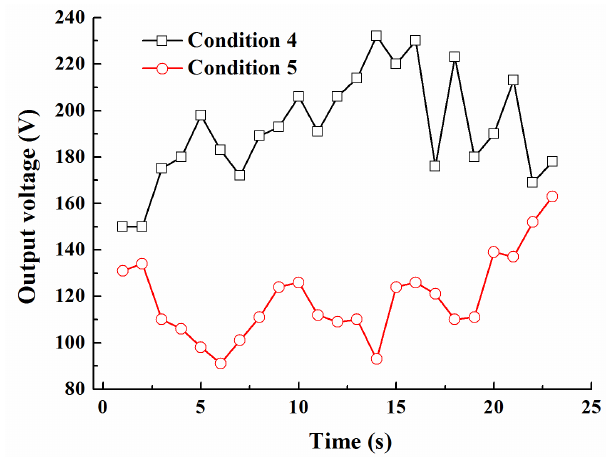
Figure 14. Voltage output under relative-motion